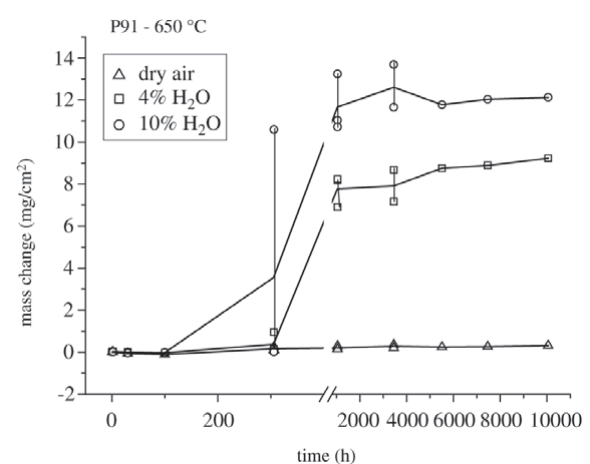
Figure 4. Results of mass change measurement as a function of time for steel P91 at 650 °C in different environments.